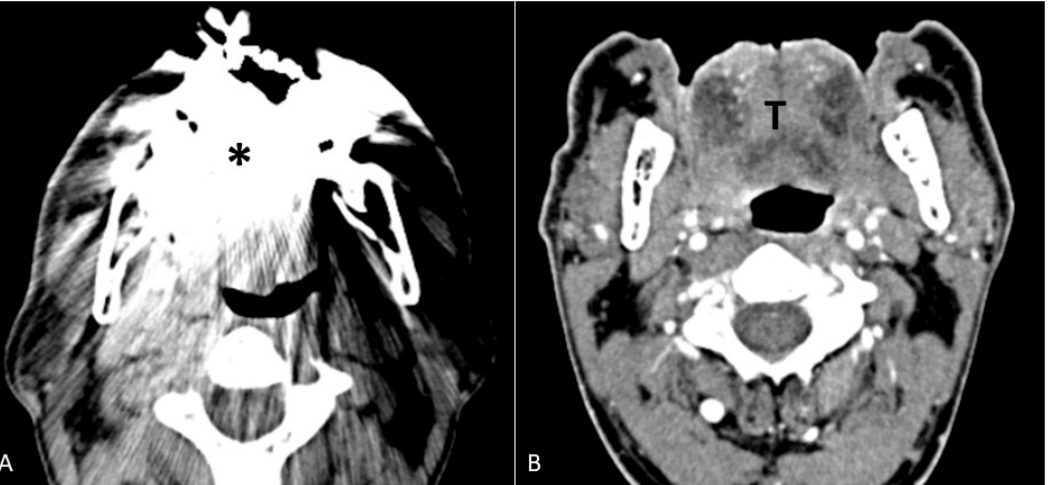
Figure 14. Open mouth MSCT technique. This technique can be also used to increase the visibility of the structures obscured by metal artifacts, especially the upper part of the mobile tongue. ( A ) Axial non-enhanced MSCT. The evaluation of the upper portion of the tongue in the standard scan is not possible due to large artifacts (*). ( B ) Axial contrast-enhanced open mouth MSCT of the same patient. The execution of the manoeuvre allows an easy assessment of the tongue (T). 3. Mouth Opened with Tongue Extended. Patient must keep the mouth open and the tongue extended for the scan time while breathing through the nose (Figures 15 and 16).